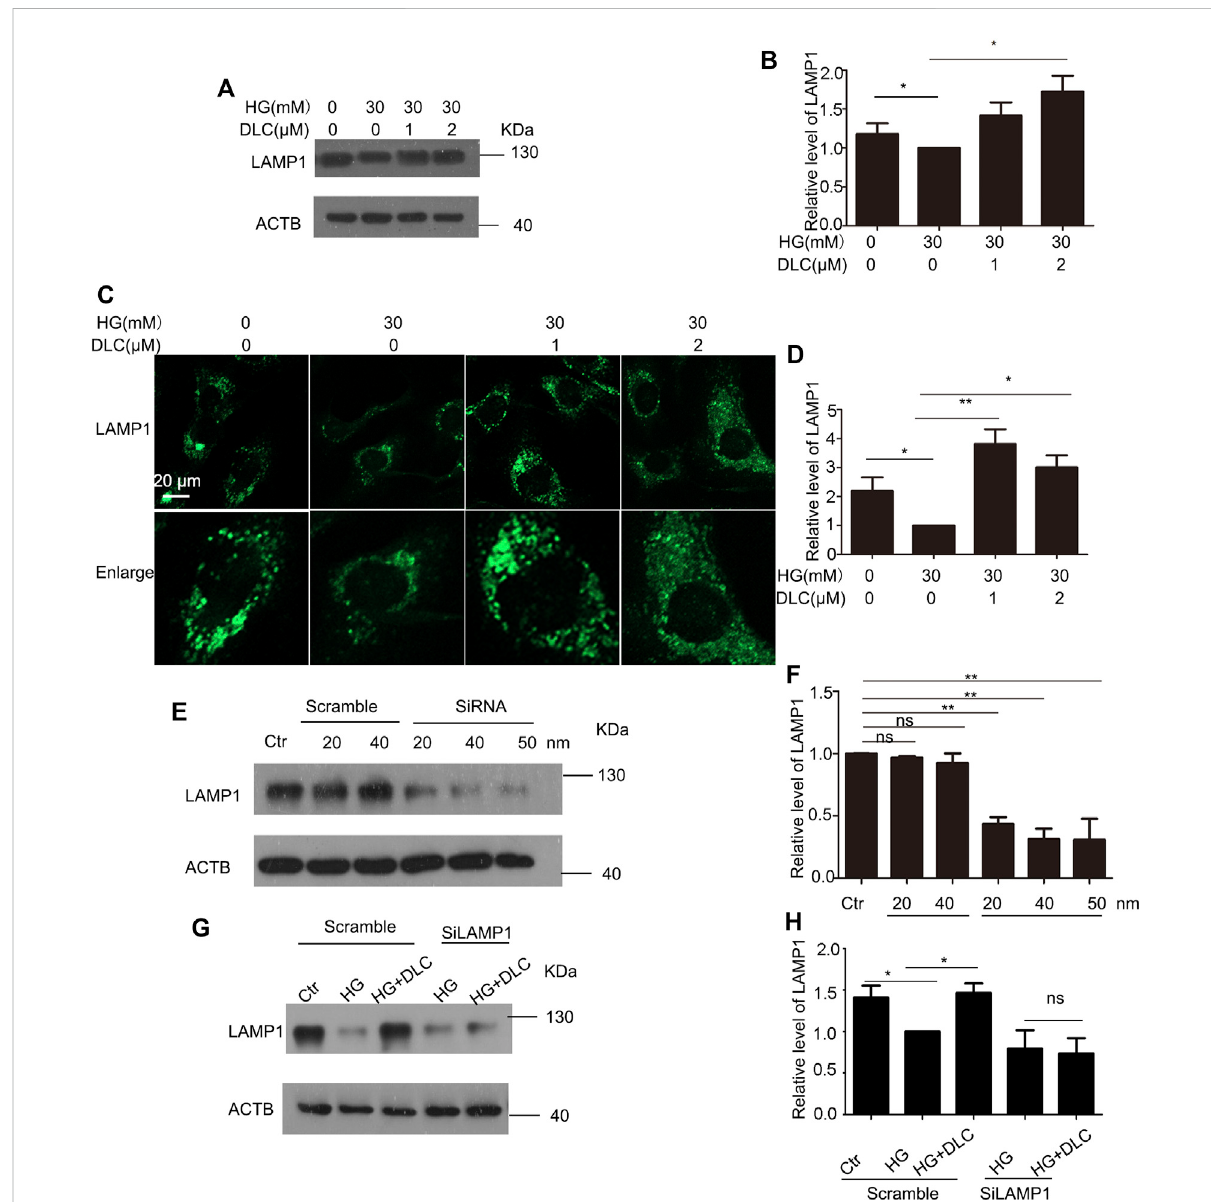
FIGURE 6 DLC protected LAMP1 level (A,B) : HUVECs were treated with DLC (1, 2 μ M) for 24 h under HG condition (30 mM) and protein levels of LAMP1 was detected by Western blot. (C,D) : HUVECs were treated with DLC (1, 2 μ M) for 24 h under HG condition (30 mM) and protein levels of LAMP1wasdetectedbyimmuno fl uorescence (E,F) :HUVECsweretreatedLAMP1siRNAwithunderHGcondition(30 mM)for24 handproteinlevels of LAMP1 was determined by Western blot. (G,H) : HUVECs were transfected with LAMP1 siRNA 24 h, DLC treated HUVECs under HG condition (30 mM) for 24 h and the LAMP1 protein level was detected by western blot. Scale bar: 20 μ m, * p < 0.05, ** p < 0.01, n =